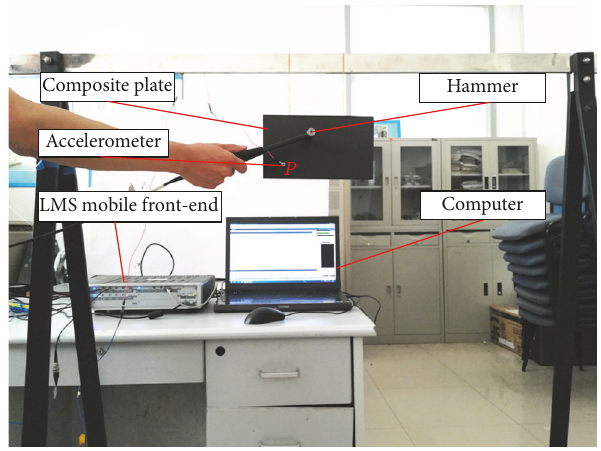
Figure 4: Actual photograph of damping test of fiber-reinforced composite thin plate.